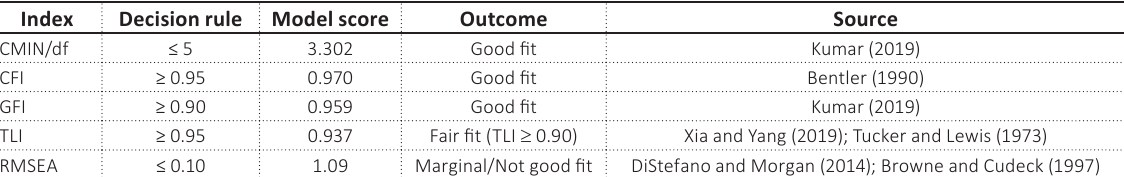
Table 4. Goodness of model fit